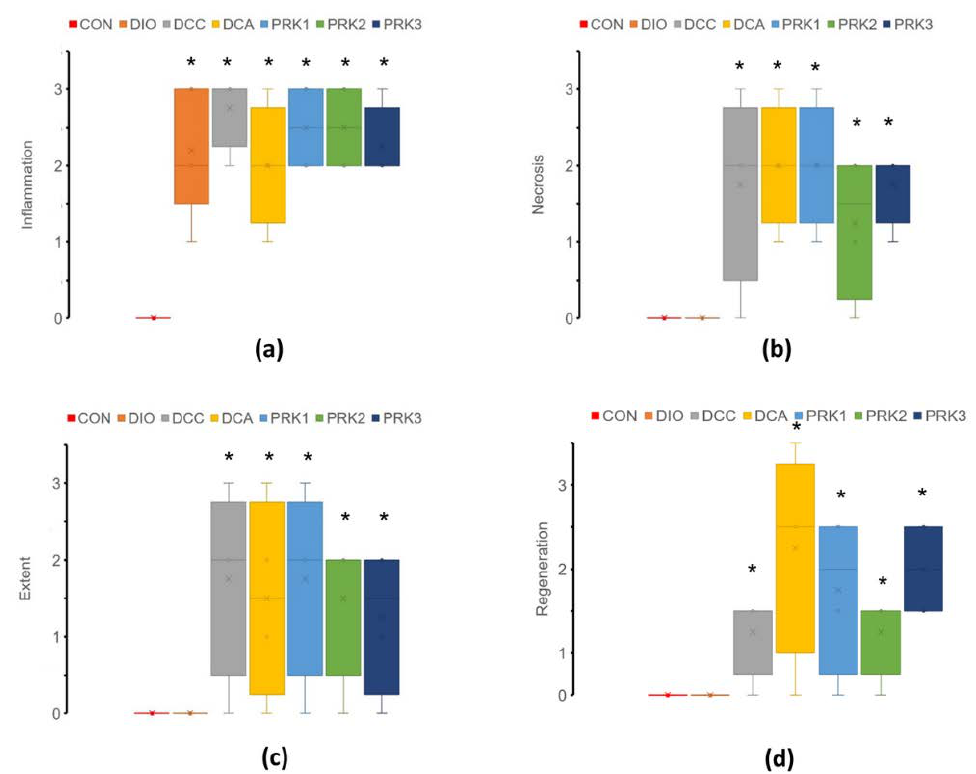
Figure 6. Histopathological colitis scores. ( a ) Inflammation; ( b ) necrosis; ( c ) extent; ( d ) regeneration. Data are expressed presented as box plots with median and quartiles as well as whiskers to express minimum and maximum values. * indicates p < 0.05 when data is compared to that for the CON group.